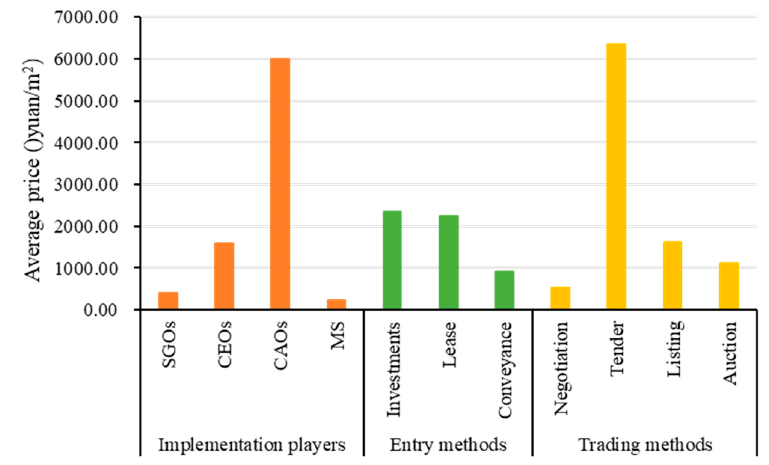
Figure 8. Prices under different market environment.